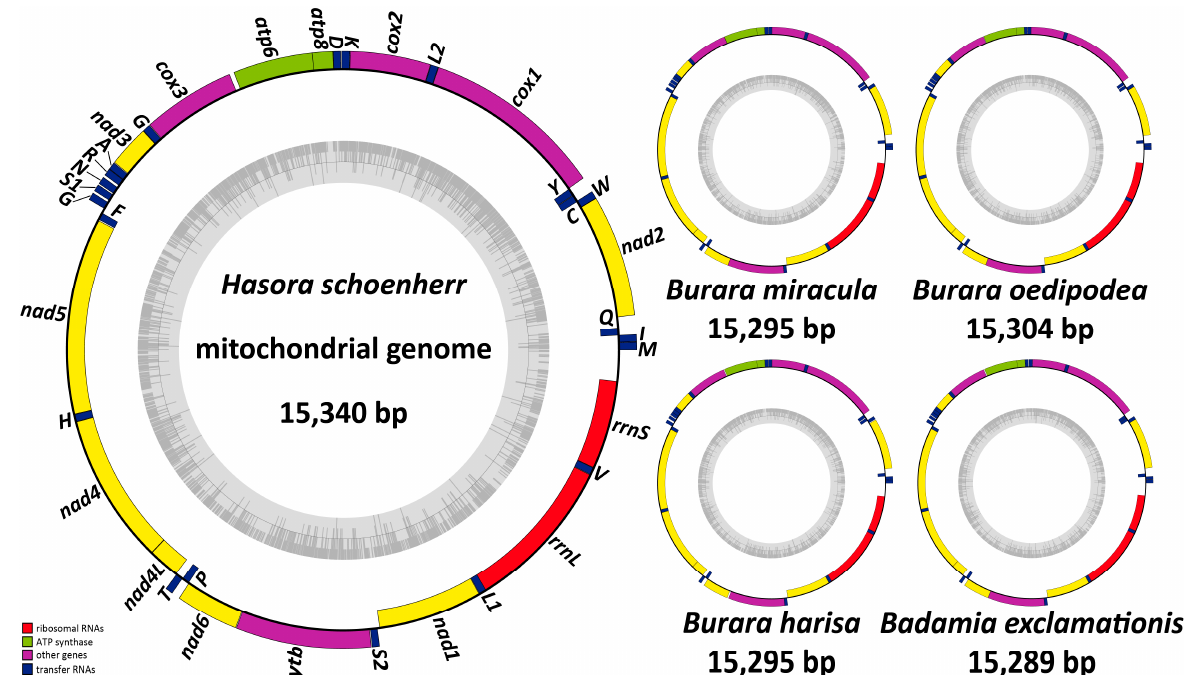
Figure 1. Circular maps of mitogenomes of five species in Coeliadinae.